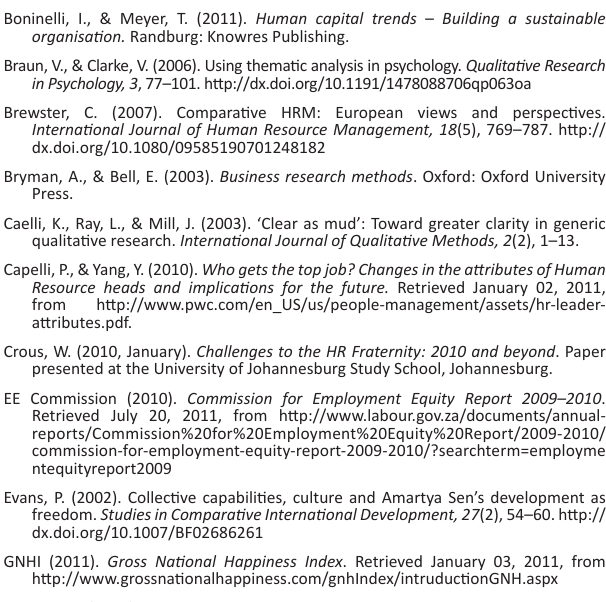
FIGURE 8: Roles of the HR